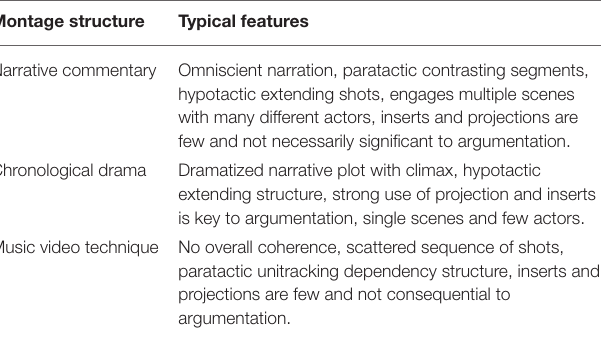
TABLE 1 | Overview of montage structures as identified in the pilot study on Ghanaian alcohol commercials. Montage structure Typical